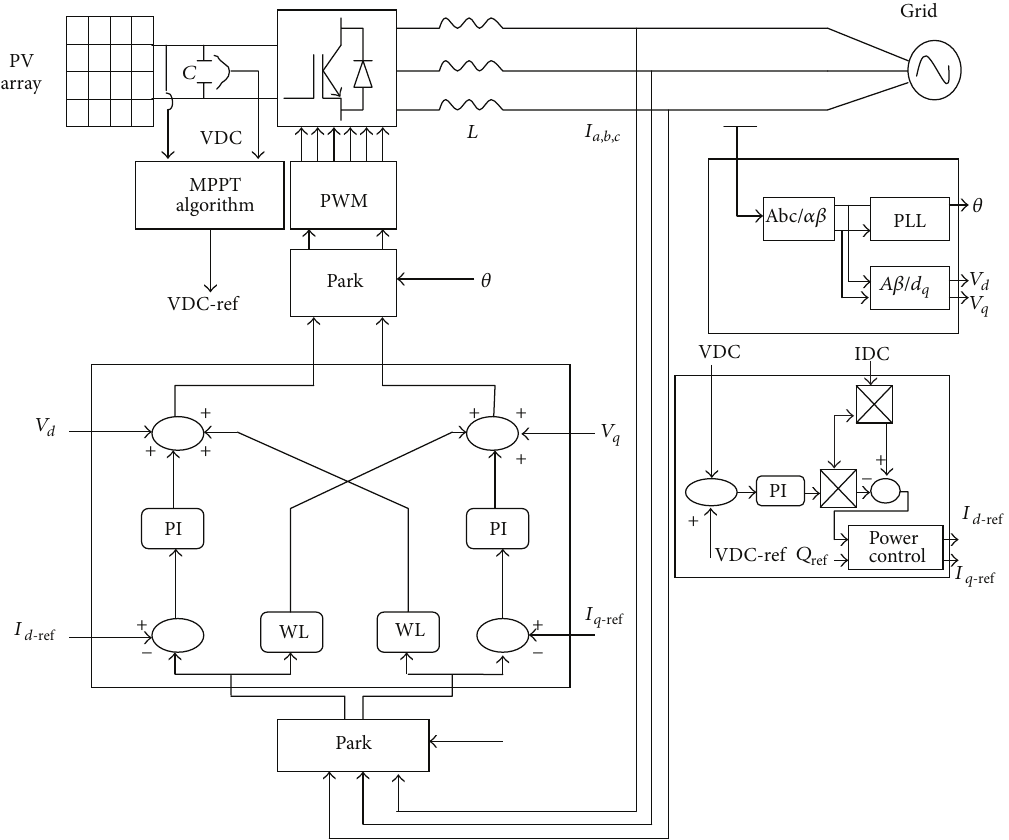
Figure 2: Schematic diagram of a connected PV-grid